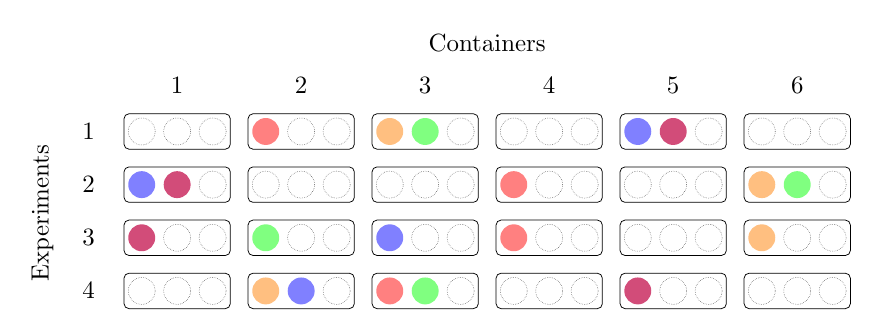
Figure 6: Outcome of 4 independent experiments of the (5 , 3 , 6)-balls-and-containers game, in which different balls are in different